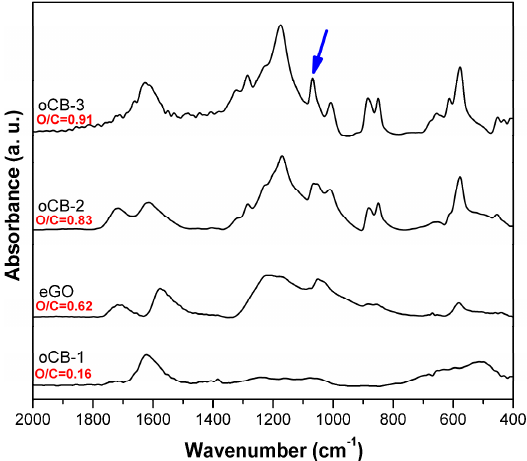
Figure 2. FTIR spectra in the range 2000–400 cm − 1 of the considered carbon nanofillers: oCB-1; eGO; oCB-2; oCB-3. Close to each curve, their O/C molar ratio is indicated.